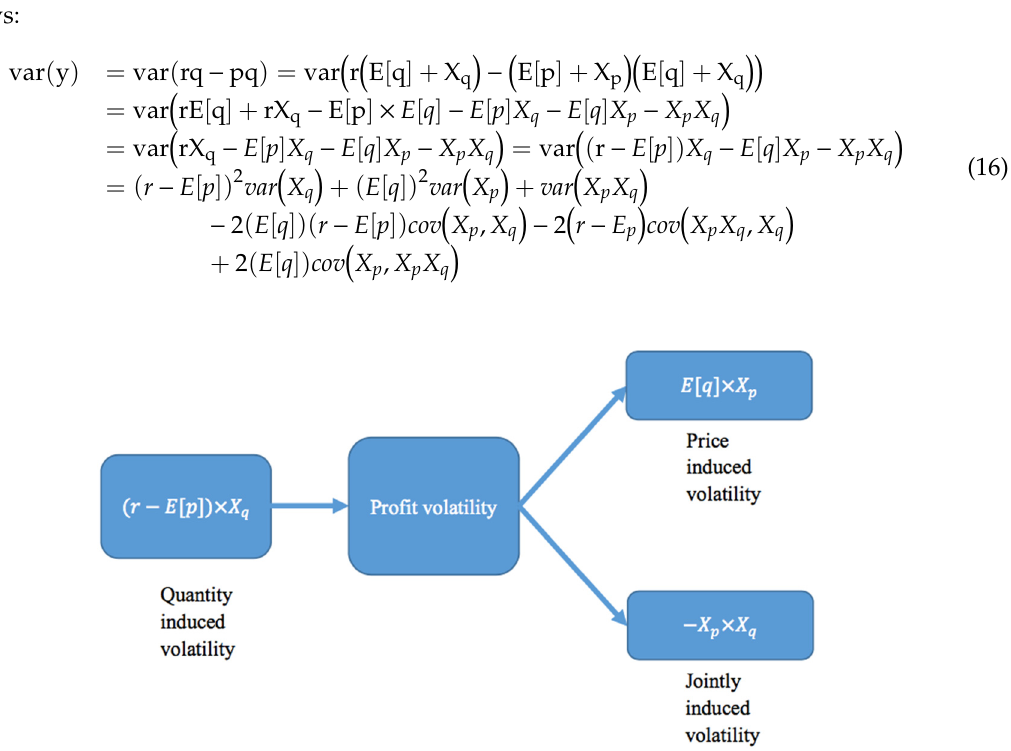
Figure 2. Profit volatility decomposition for model 2.